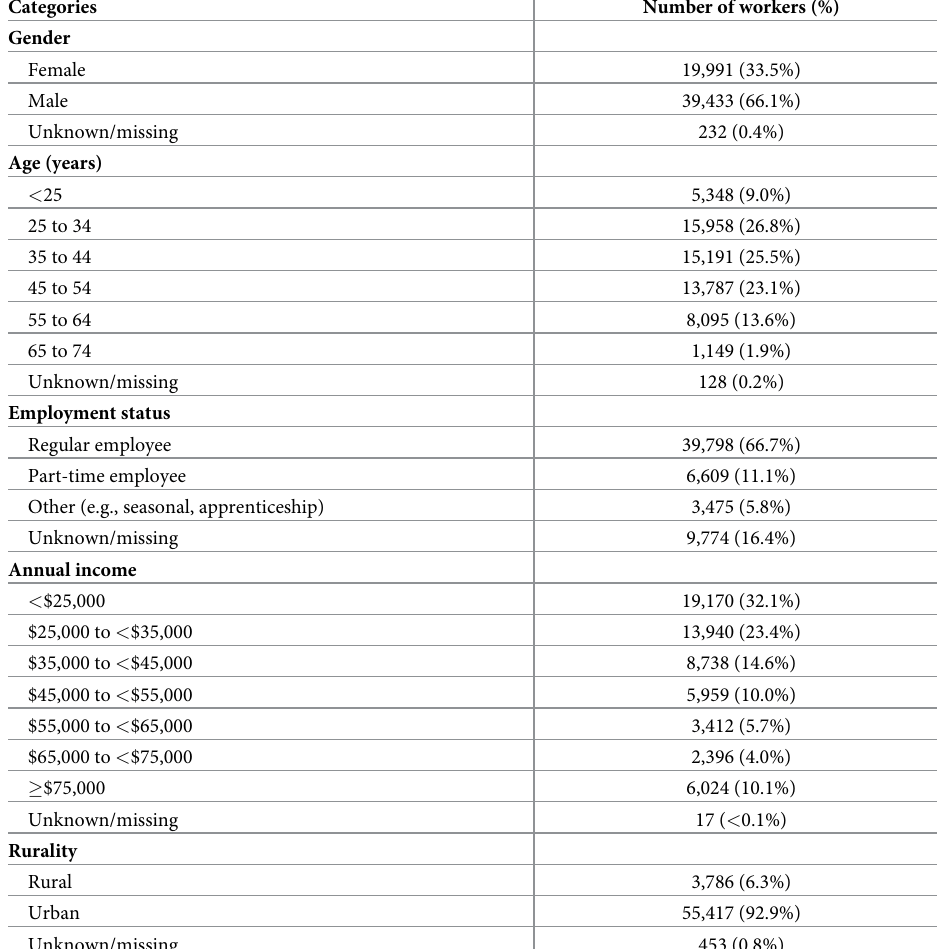
Table 1. Demographic characteristics of the study population (n =